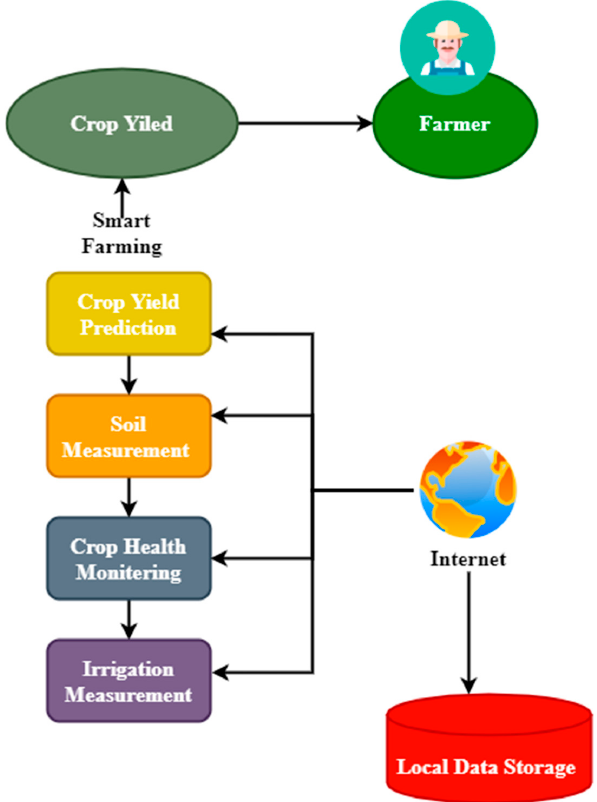
Figure 6. Crop yield prediction-based smart agriculture and data